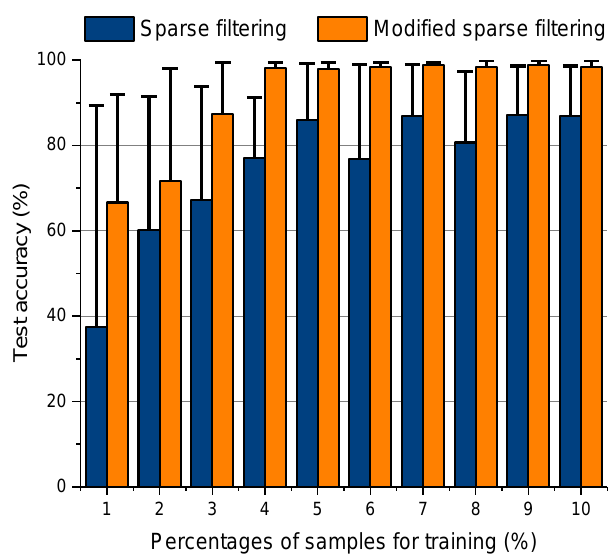
Figure 18. Diagnosis result trained by different percentages of samples using modified and original sparse filtering.